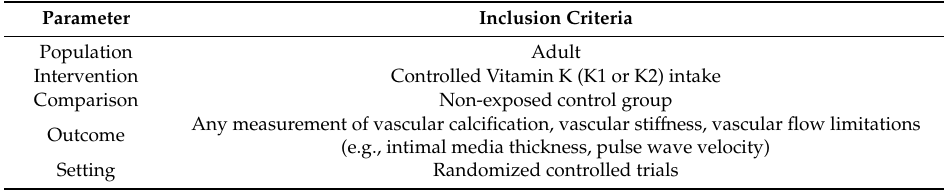
Table 1. PICOS (Population, Intervention, Comparison, Outcomes and Settings) criteria for the inclusion of studies evaluating the e ff ects of vitamin K supplementation on vascular